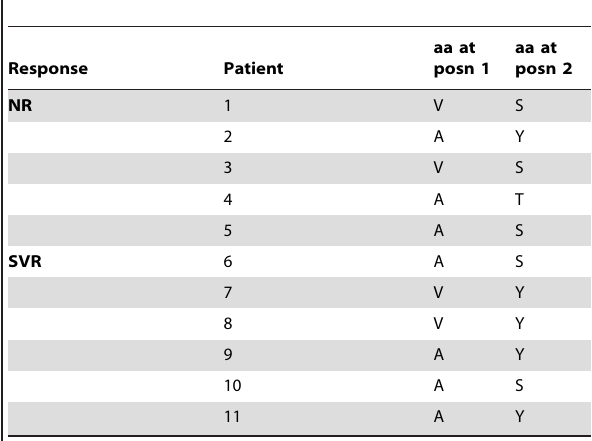
Table 1. Example of separating pairs. aa pairs at positions 1 and